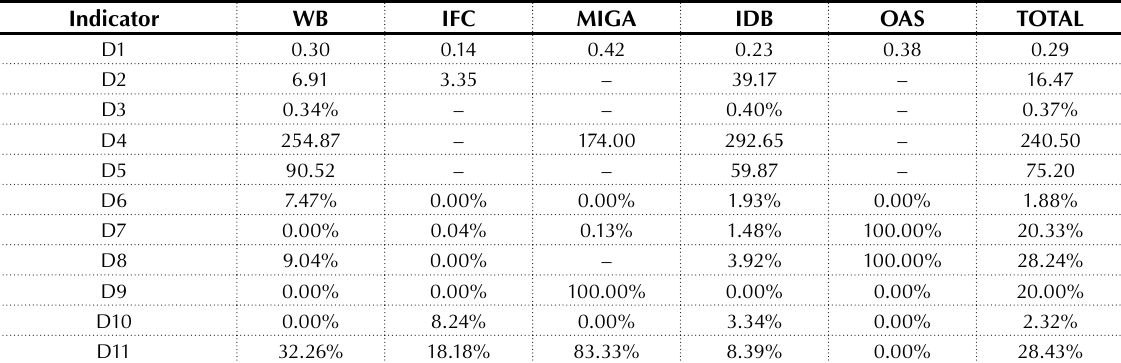
Table 11. Indicators for the study of the characteristics of the funding, results